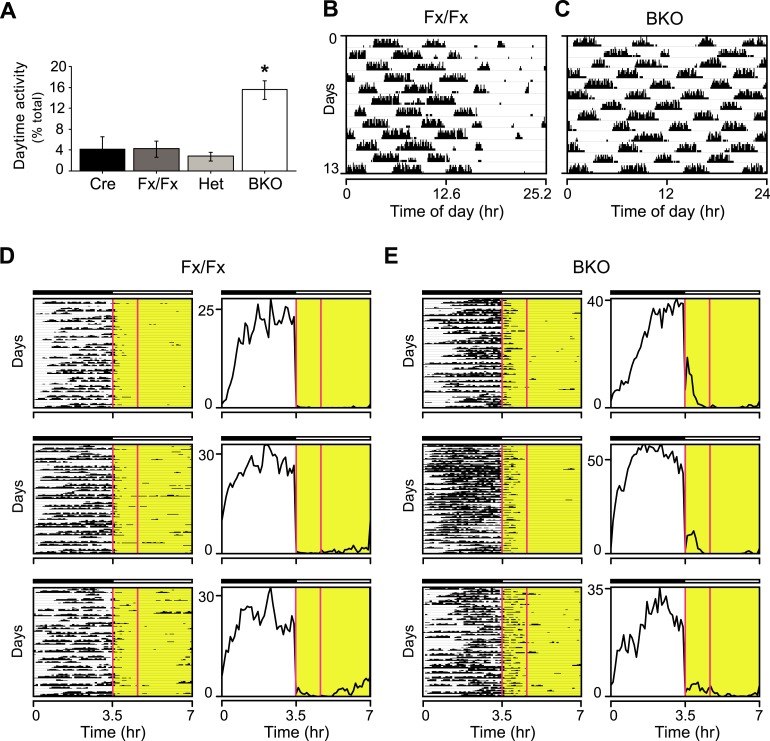
Masking in Bmal1 brain knockout mice.(A) Daytime activity levels during LD, as percentage of total daily activity, in Cre (n = 12), Fx/Fx (n = 18), Het (n = 13), and BKO (n = 16) mice. A significant effect of genotype on daytime activity was found by GLM ANOVA [F3,58 = 12.43, p < 0.0001], with BKO mice having significantly higher daytime activity by Tukey–Kramer multiple comparisons post-test (*p ≤ 0.05). Combined, controls allocate an average of 3.81 ± 0.96% of their total activity to running during the daytime. In contrast, 15.58 ± 1.8% of BKO wheel-running activity occurs during the light phase. (B–E) Shown are days 3–15 of a 21-day LD 3.5:3.5 cycle; these are the same days as those shown in Figure 3A,B. (B, C) Representative single-plotted actograms of daily wheel-running activity of (B) Fx/Fx and (C) BKO littermates. These are the same mice as those shown in Figure 3A (middle panel), 3B (middle panel), and 3G. Actograms are plotted modulo tau (25.2 hr for B) to help visualize the circadian ‘beating’, that is the gaps in activity in controls (B) caused by the suppressive effects of the light phases of the LD 3.5:3.5 cycle on running. A circadian component of wheel-running activity is clearly evident in controls (B) but absent in BKOs (C). (D, E) Representative actograms of wheel-running activity of Fx/Fx (D) and BKO littermates (E), plotted on a 7 hr time scale (x axis). Y-axis shows successive 7 hr spans for days 3–15 of this cycle. The gaps in activity in some of the dark periods in Fx/Fx controls represent times when the circadian cycle is specifying rest even though lights are off (see Figure 3G, left panel). To the right of each actogram is an activity profile for that individual mouse, averaged over 13 days. Each data point represents counts per minute averaged for each mouse across a 6-min bin. The boxed area corresponds to the first one-third of all the light phases of the LD 3.5:3.5 schedule. Substantial BKO wheel-running activity is seen during this interval, especially the first 30 min, during which BKOs fail to mask altogether (see Figure 3F). Horizontal black and white bars represent lights off and on, respectively.